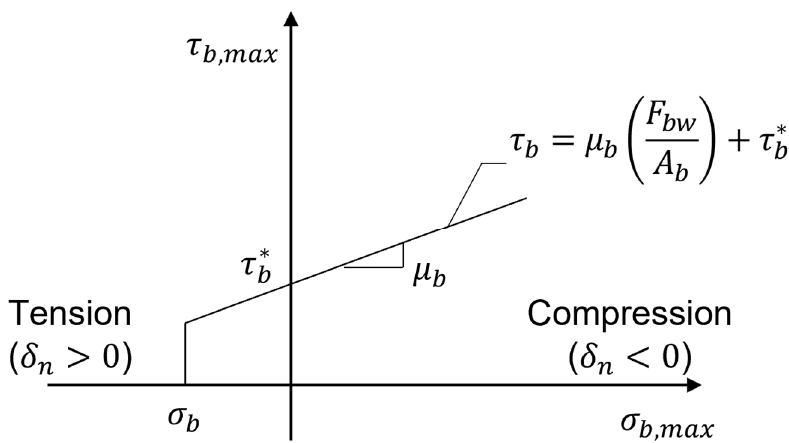
Figure 2. Bond failure envelope with Mohr-Coulomb failure criterion [17].